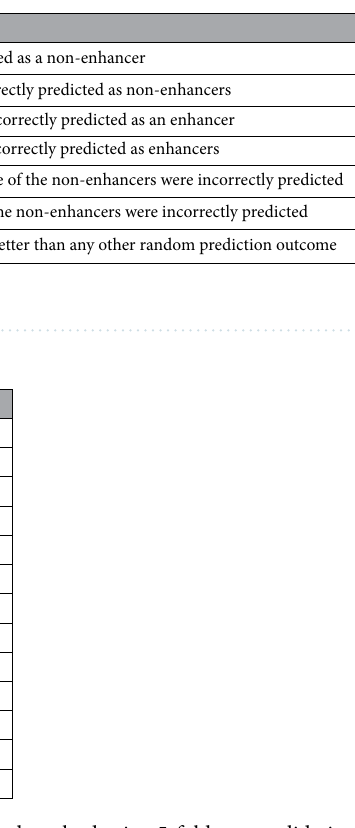
Table 4. Comparison of state-of-the-art methods with the proposed method using 5-fold cross validation tests.